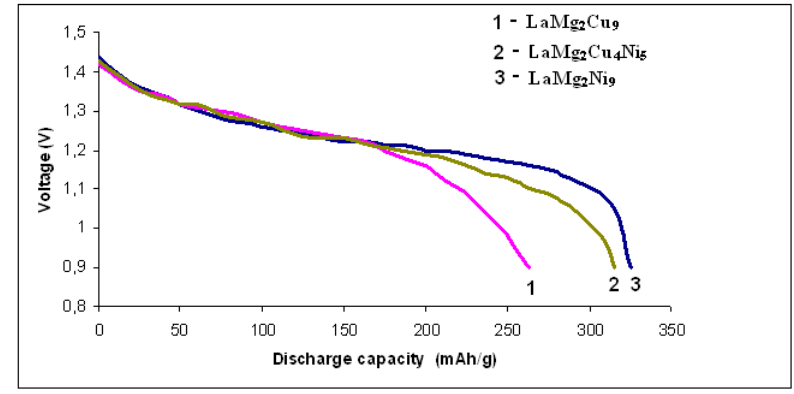
Figure 10. Discharge curves of the LaMg